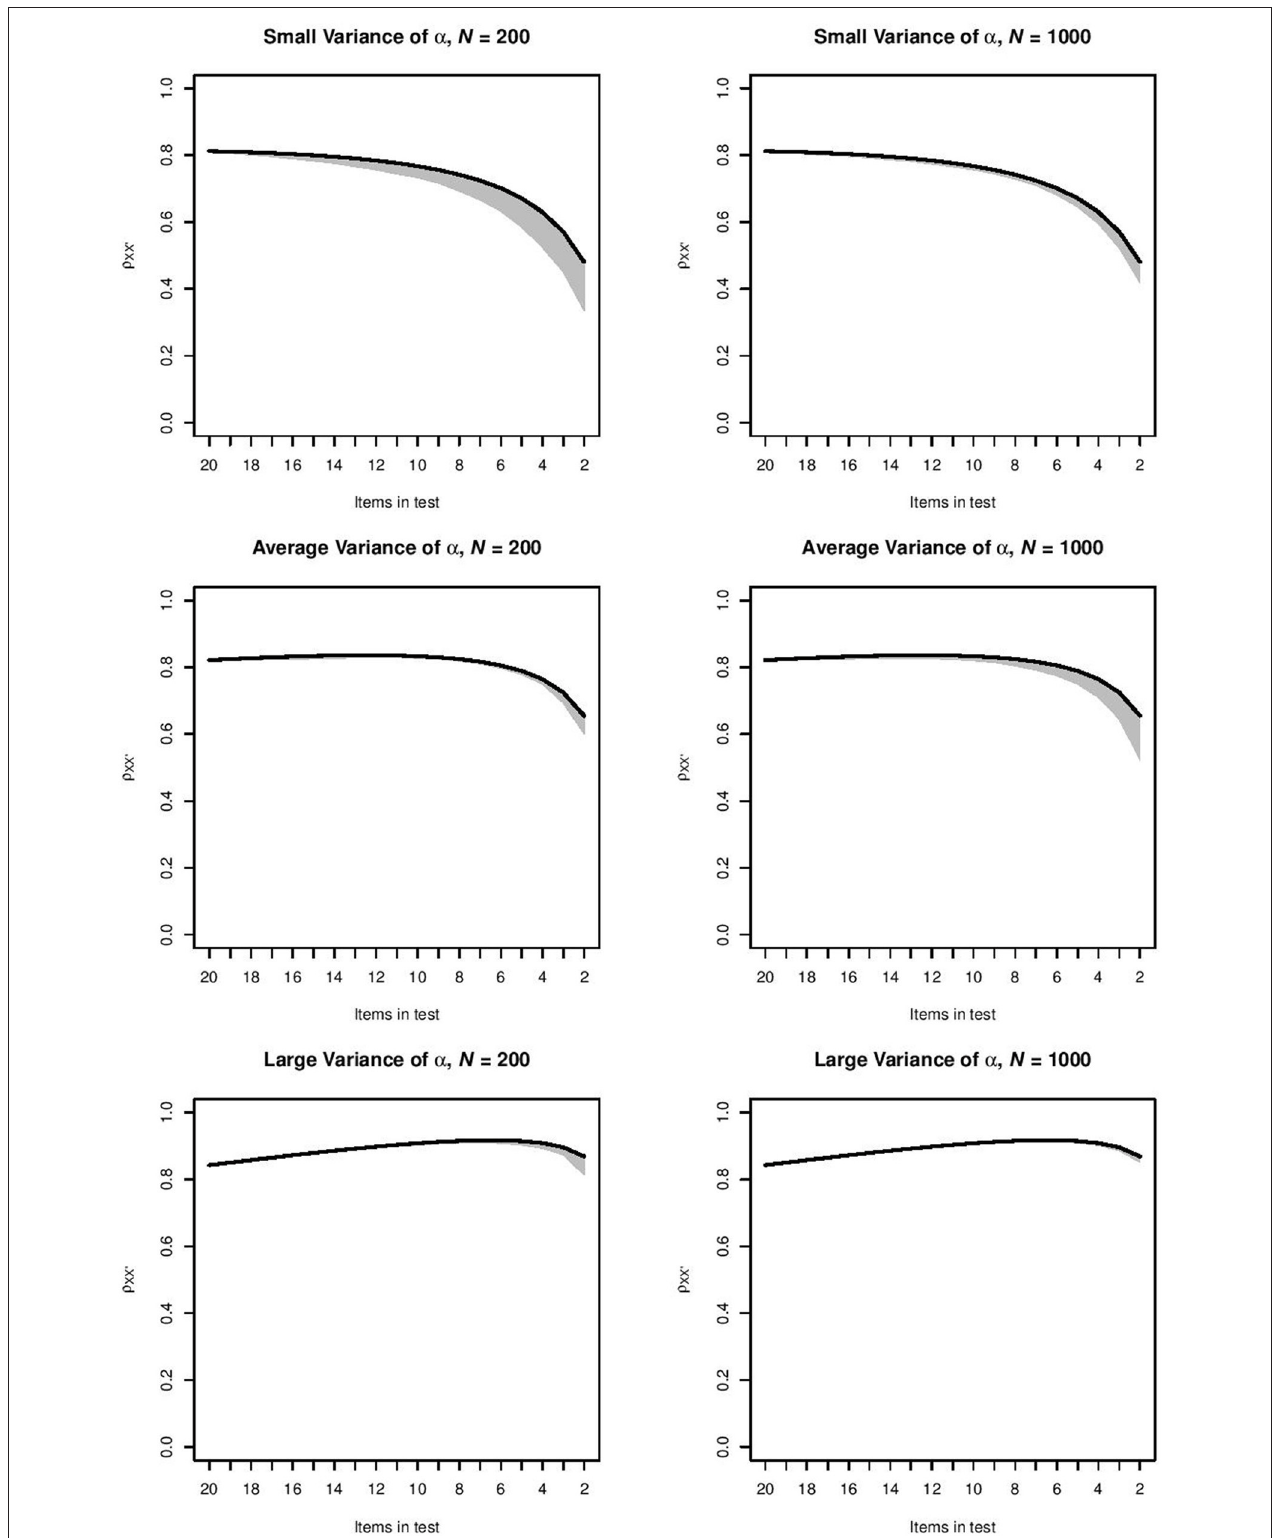
FIGURE 1 | Range of ρ XX ′ -values between the 2.5 and 97.5 percentiles of 1,000 values produced by method CA in the six conditions for the top-down procedure. The black line indicates the ρ XX ′ -value for the ideal ordering.